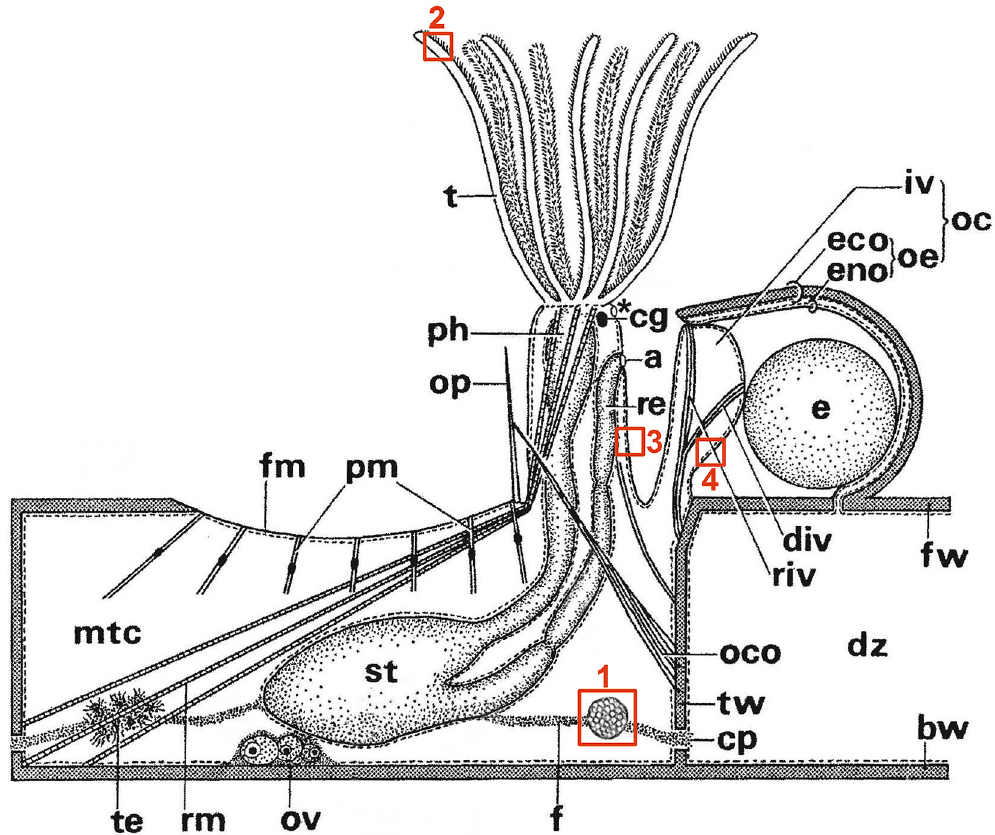
Figure 2. Scheme of cheilostome fertile autozooid with protruded tentacle crown and embryo in the brood chamber (ovicell) formed by distal autozooid (shown in part). Boxes indicate the sites where bacteria were found. Box 1, funicular body (corresponds to Fig. 1C,D); box 2, tentacle epithelium (corresponds to Fig. 5); box 3, wall of tentacle sheath (introvert) —flexible part of the body wall everting and inverting during the tentacle expansions and retractions; box 4, wall of the inner (ooecial) vesicle—outfold of the body wall plugging the entrance to the ovicell (brood chamber) (corresponds to Fig. 7A,B). Abbreviations: a, anus; bw, basal wall; cg, cerebral ganglion; cp, communication pore; div, depressor muscle of inner (ooecial) vesicle; dz, distal zooid; e, embryo; eco, ectooecium; eno, entooecium; f, funiculus; fm, frontal membrane; fw, frontal wall; iv, inner (ooecial) vesicle; mtc, coelom of maternal zooid; oc, ovicell; oco, occlusor of operculum; oe, ooecium; op, operculum; ov, ovary; ph, pharynx; pm, parietal muscles; re, rectum; riv, retractor muscle of inner (ooecial) vesicle; rm, retractor muscle of polypide; st, stomach; t, tentacles; te, testis; tw, transverse wall. Asterisk indicates supraneural coelomopore (from Ryland 1970,